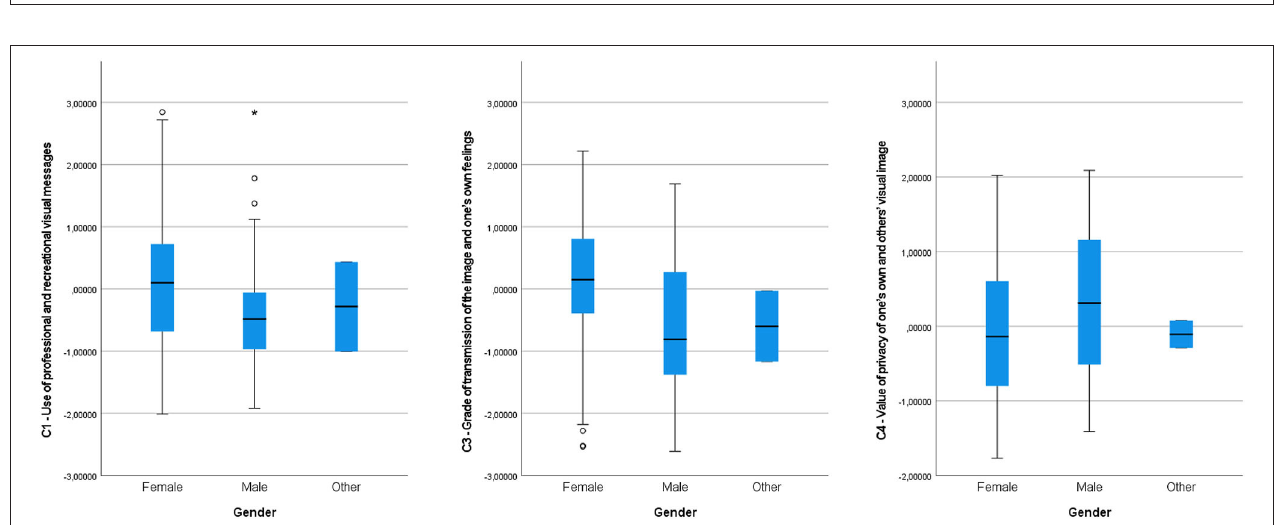
FIGURE 2 | Comparative components 4 and 5 with specialties AL, LEI, and RE.